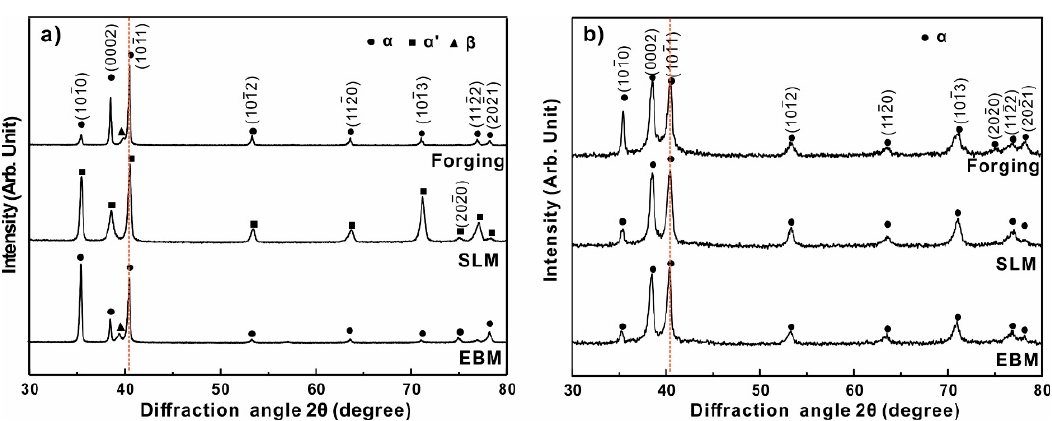
Figure 2. X-ray diffraction (XRD) analysis of Ti-6Al-4V samples produced by forging, selective laser melting (SLM) and electron beam melting (EBM) processes: ( a ) before sliding wear tests, ( b ) the tribo-layer surface after sliding wear tests.